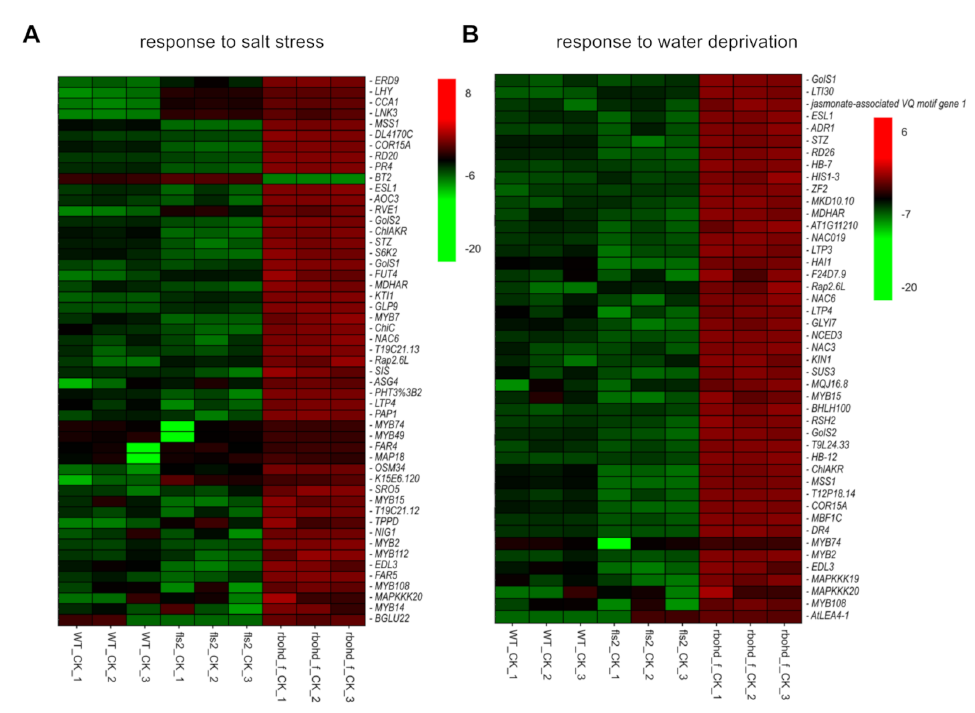
Figure 4. The expression of genes related to drought and salt stress was constitutively activated in rbohd rbohf double mutant. ( A , B ) Heatmap analysis of genes expression related to salt and water privatization response in WT, fls2 mutant, and rbohd rbohf double mutant under normal growth conditions, respectively. CK: